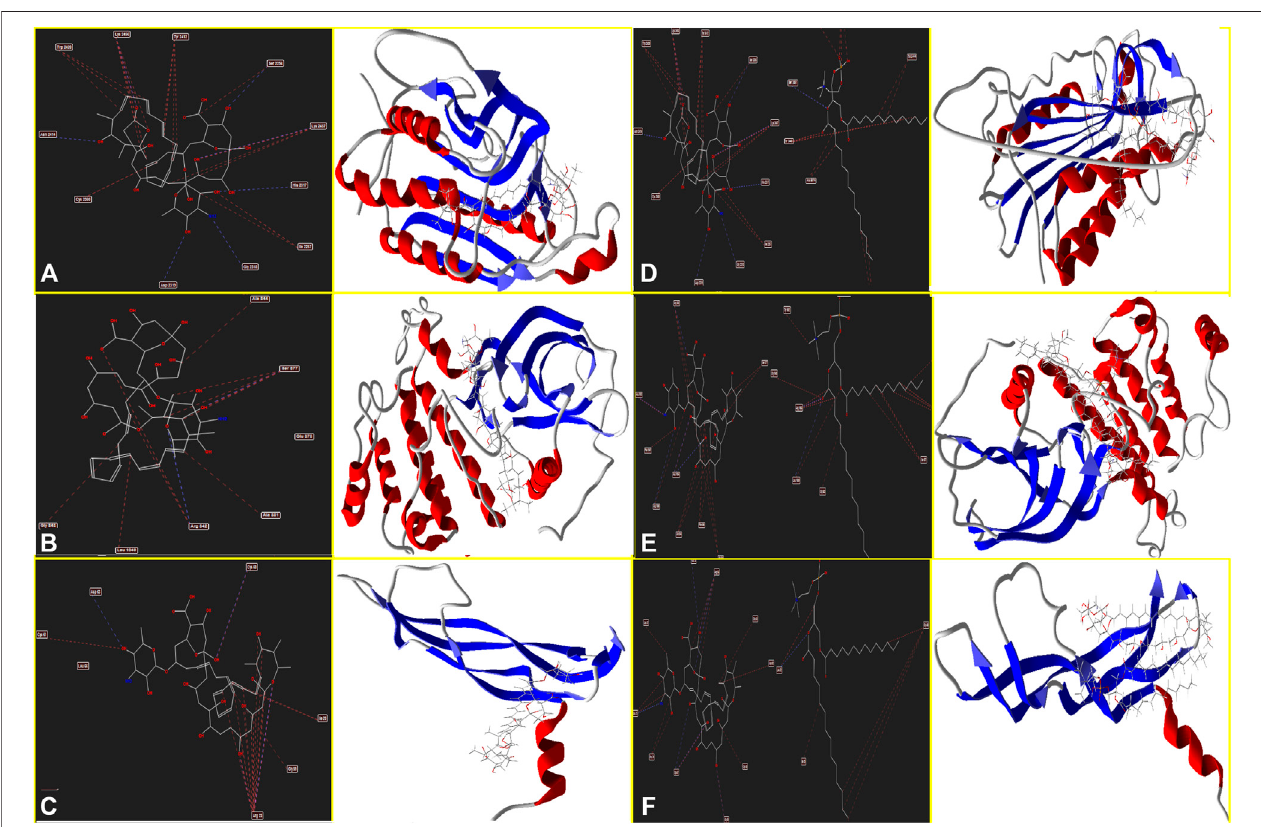
FIGURE4 | Schematic ofthe best score docking solution ofthe Amp B ligands and (A) Caspase-8, (B) KDR1, (C) VEGF-A targetand AmBisome, (D) Caspase-8, (E) KDR1, and (F) VEGF-A target with the selected crystal structure of 1I4E, 2QU5, and 5t89, respectively, along with the pharmacophore and ligand map of MMV 7.0.